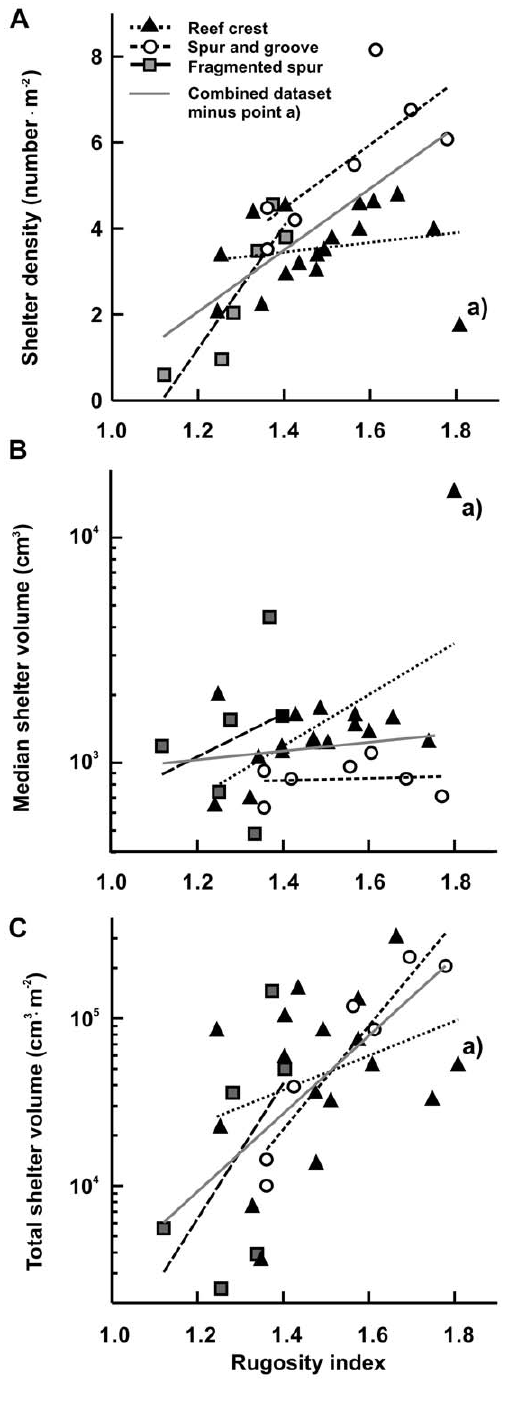
Figure 4. Shelter availability variables in relation to structural complexity. The relationship between A) shelter density (number m 2 2 ), B) median shelter volume (cm 3 ), C) total shelter volume (cm 3 m 2 2 ) and mean rugosity index across the 30 quadrats sampled. Lines represent the best fit linear regressions for each zone considered separately (reef crest – dotted, spur and groove – short dashes, fragmented spurs – long dashes). The solid gray line represents the best fit linear regression for the entire dataset, excluding the data point recorded at the highest value of rugosity (Quadrat 5, point a).